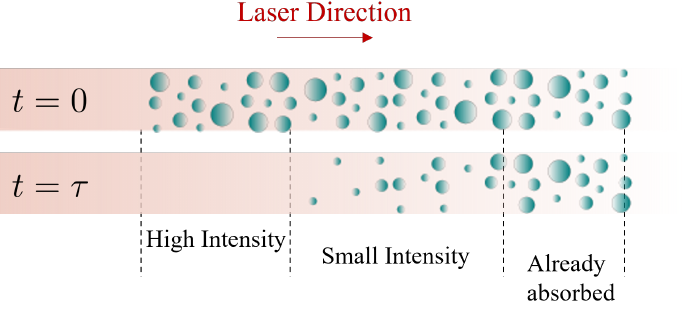
Figure 15. Schematic showing the laser bleaching